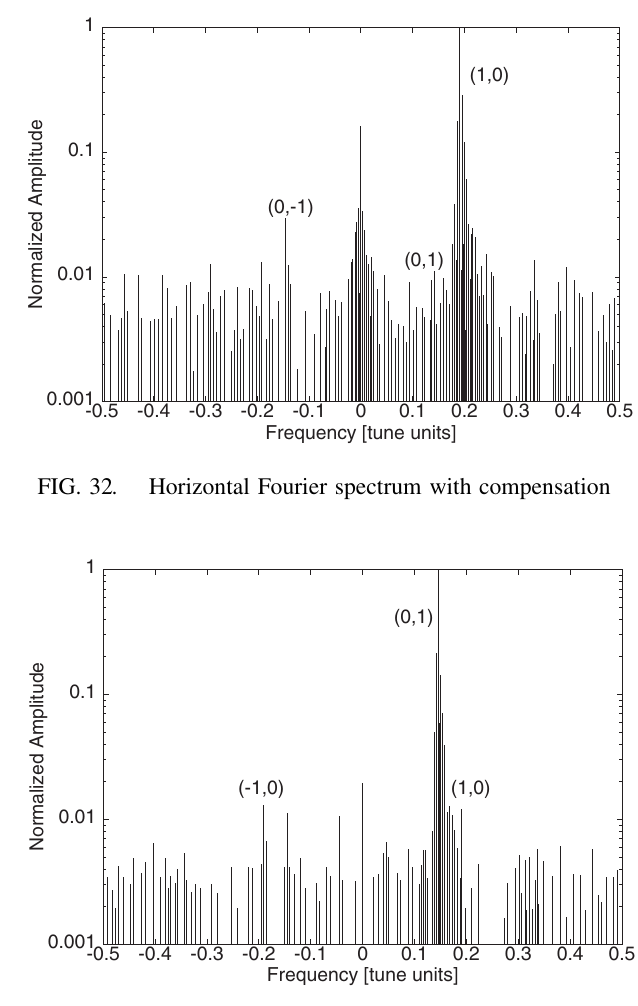
FIG. 33. Vertical Fourier spectrum with compensation. the linear coupling difference resonance. The labeled lines (cid:2) 0 ; (cid:1) 1 (cid:3) and (cid:2)(cid:1) 1 ; 0 (cid:3) belong to the linear coupling sum resonance.